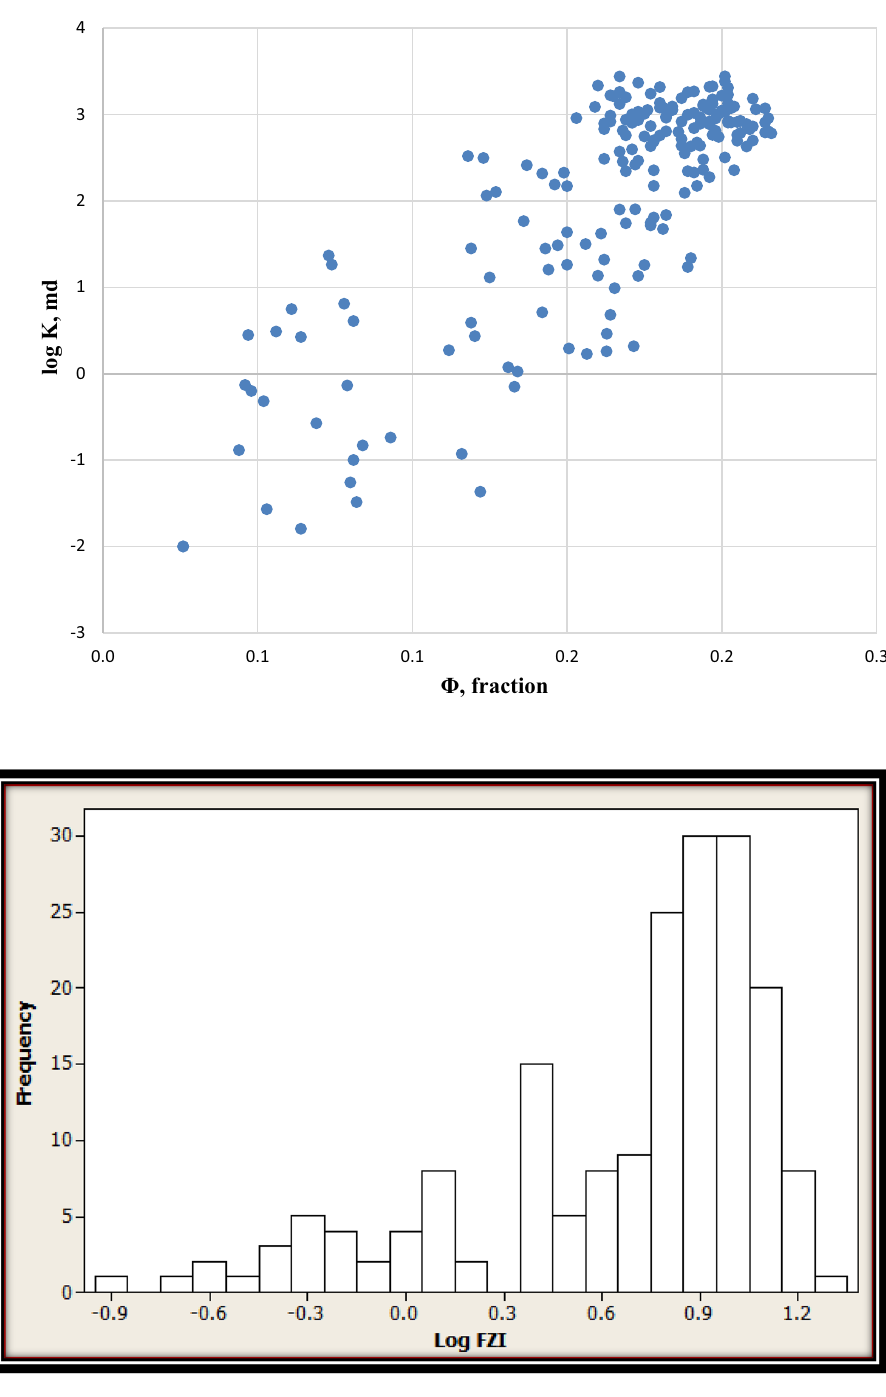
Fig. 4 Cross-plot of porosity versus log permeability of the studied cored wells